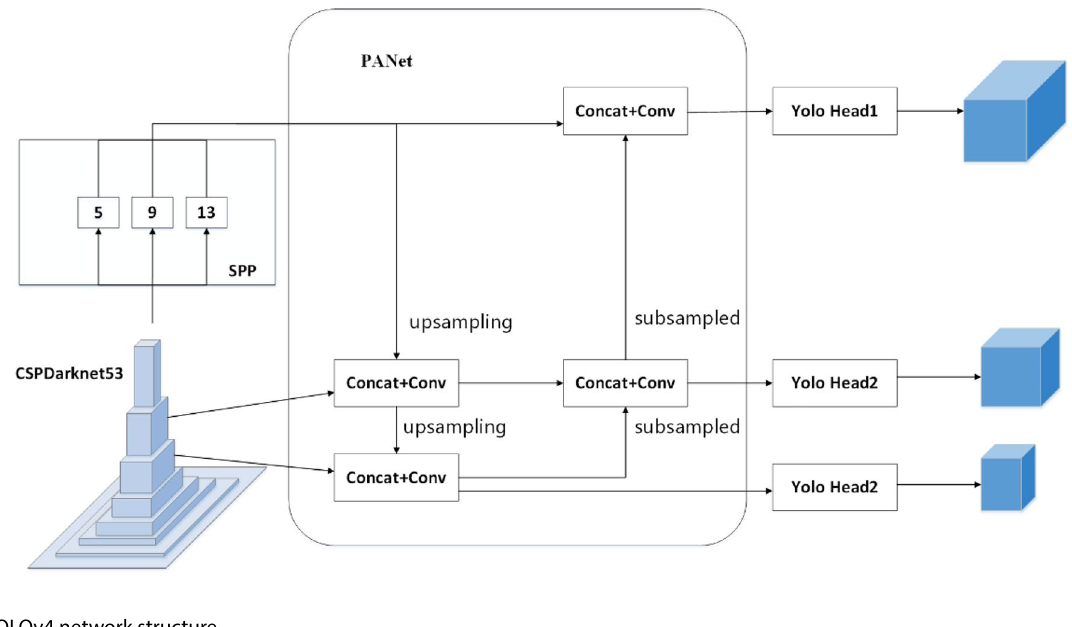
Fig. 1 YOLOv4 network structure